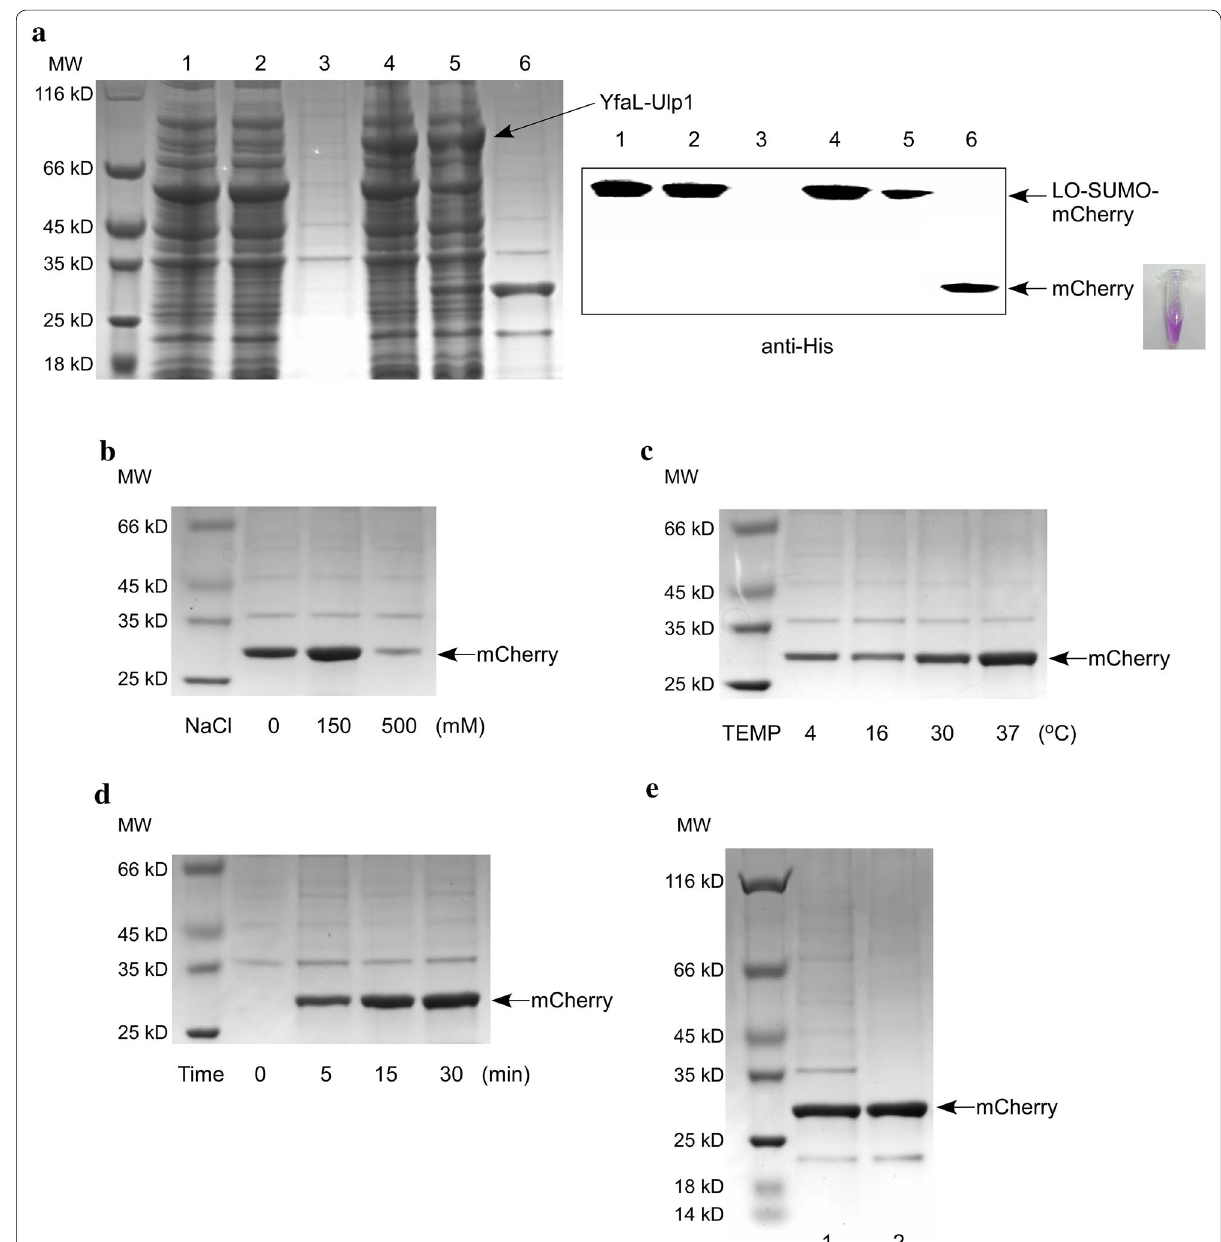
Fig. 4 Cleavage of surface‑expressed SUMO‑fused mCherry by surface‑expressed Ulp1 and purification of mCherry. a SDS‑PAGE analysis (left panel) and western blot (right panel) of surface‑displaying bacterial cells and released target protein fractions. IPTG‑induced E. coli cells (pET‑LO‑SUMO‑mCherry/BL21 and pET‑YfaL‑Ulp1/BL21) were incubated together in cleavage buffer at 37 °C for 30 min, after which the cells and the buffer solution were immediately separated by centrifugation. Lane 4: cell pellets before incubation; lane 5: cell pellets after incubation; lane 6: supernatant fraction after incubation. The negative control (pET‑LO‑SUMO‑mCherry/BL21 and pET/BL21) was prepared using the same procedures (Lane 1–3). Cleavage was conducted under different conditions of ionic strength ( b ), temperature ( c ), and incubation time ( d ) to optimize the cleavage efficiency and mCherry protein yield. The supernatant fraction after cleavage and centrifugation was analyzed by SDS‑PAGE. e SDS‑PAGE analysis of purified mCherry protein prior to (lane 1) or after (lane 2) ultrafiltration using a 30‑kDa ultrafiltration tube. The results are representative of three independent